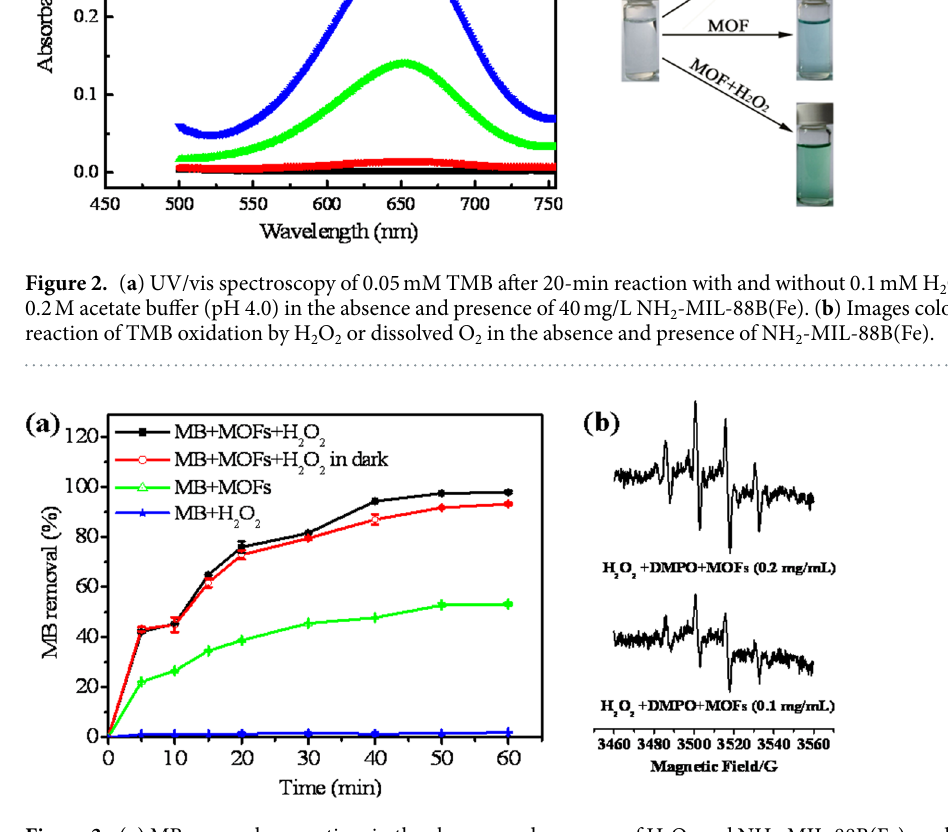
Figure 3. ( a ) MB removal versus time in the absence and presence of H 2 O 2 and NH 2 -MIL-88B(Fe) on different conditions. Reaction conditions: pH 5.6, 0.2 g/L of NH 2 -MIL-88B(Fe), 0.2 M of H 2 O 2 , 20 mg/L of MB. Error bars represent one standard deviation for three measurements. ( b ) The effect of the concentration of NH 2 -MIL- 88B(Fe) on the hydroxyl radical formation in the H 2 O 2 -DMPO